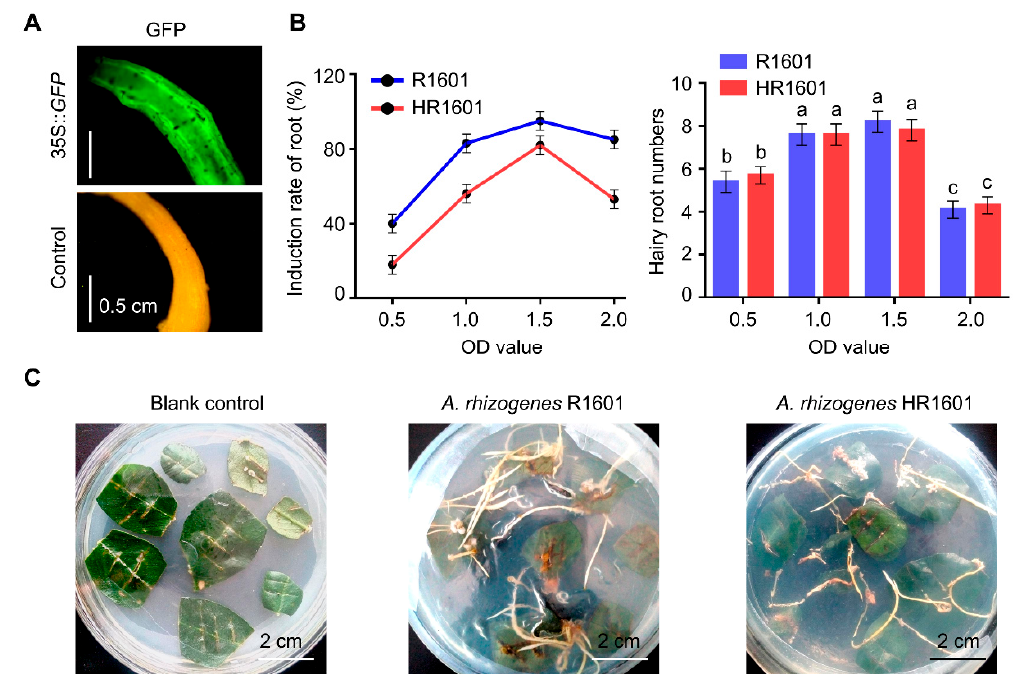
Figure 1. The establishment of peanut hairy root protein expression system. ( A ) Green fluorescence Pof the peanut hairy roots detected by fluorescent inverted microscopy. 35S:: GFP , peanut hairy roots developed from leaves infected with the recombined GFP construct. Control, peanut hairy roots developed from leaves infected with Agrobacterium rhizogenes R1601. ( B ) The induction rate and total numbers of peanut hairy roots inoculated with various concentrations of R1601 and HR1601 ( Agrobacterium rhizogenes R1601 transformed with human epidermal growth factor (hEGF)). The best induction rate is obtained when its OD 600 value reached 1.5 both for R1601 and HR1601. Error bars indicate SEM ( n = 3), p < 0.05. One-way ANOVA Duncan’s test is used for statistical analysis. Statistical di ff erences are indicated by lowercase letters and di ff erent letters represent di ff erent significance. This experiment was repeated three times with similar results. ( C ) Peanut leaves infected with Agrobacterium rhizogenes R1601 or HR1601 with hairy roots formation. Blank control, non-infected peanut leaves with no hairy roots